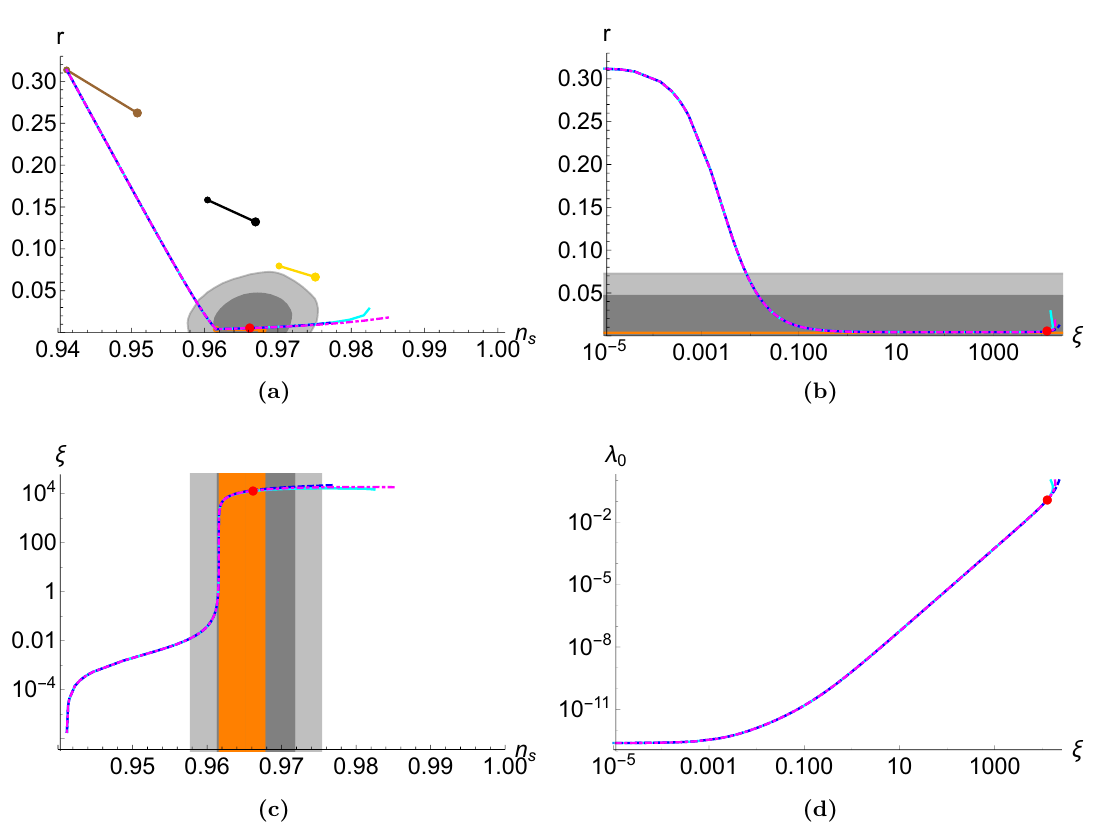
Figure 1 . Metric formulation: r vs. n s (a), r vs. ξ (b), ξ vs. n s (c) and λ 0 vs. ξ (d) for λ eff = λ app (cyan), λ eff = λ I (blue, dashed) and λ eff = λ II (magenta, dot-dashed) with N e = 50 e -folds. The red point indicates the loss of accuracy of the present analysis. For reference we also plot predictions of quartic (brown), quadratic (black) and linear (yellow) inflation for N e ∈ [50 , 60] . The gray areas represent the 1 , 2 σ allowed regions coming from Planck 2018 data [9].